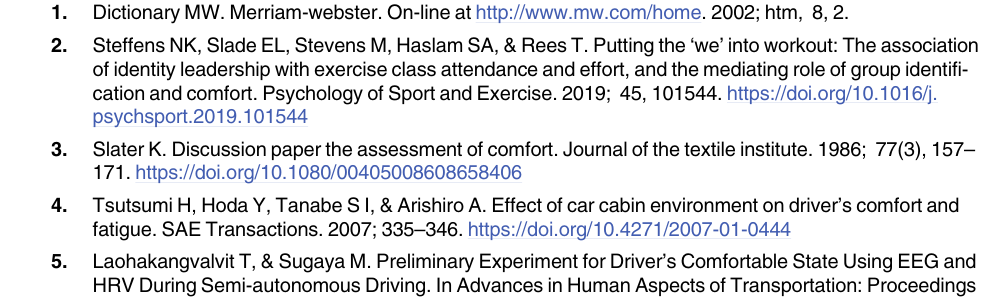
S2 Table. The judgment matrix data of light environment. The table contains the judgment matrix of the second-class indexes C . It is used to obtain the corresponding second-class 4 − C 6 weights. S3 Table. The judgment matrix data of thermal environment. The table contains the judg- ment matrix of the second-class indexes C . It is used to obtain the corresponding sec- 7 − C 10 ond-class weights. S4 Table. The judgment matrix data of human-computer interaction. The table contains the judgment matrix of the second-class indexes C . It is used to obtain the correspond- 11 − C 15 ing second-class weights. S5 Table. The judgment matrix data of first-class index. The table contains the judgment matrix of the first-class indexes B . It is used to obtain the corresponding first-class 1 − B 4